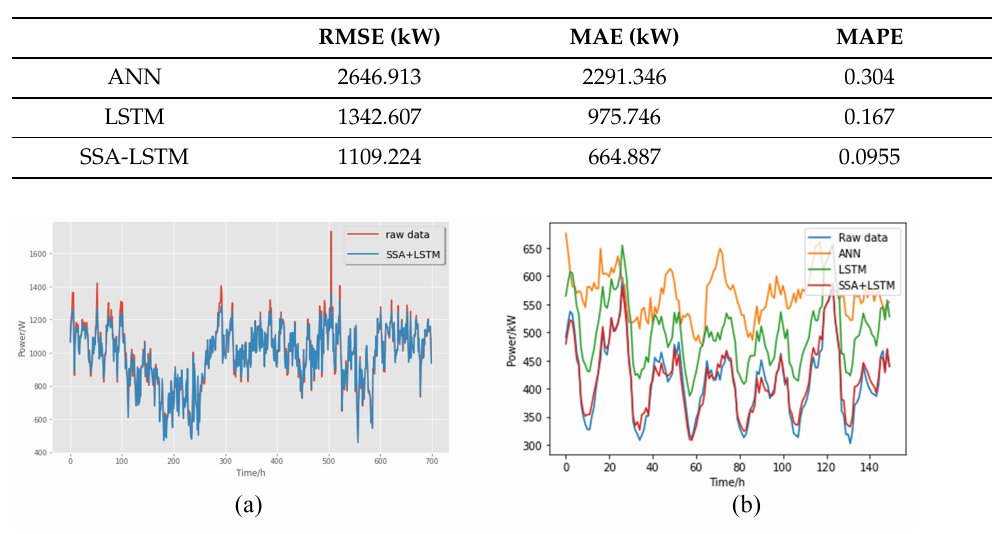
Table 2. Comparison between Different Models.